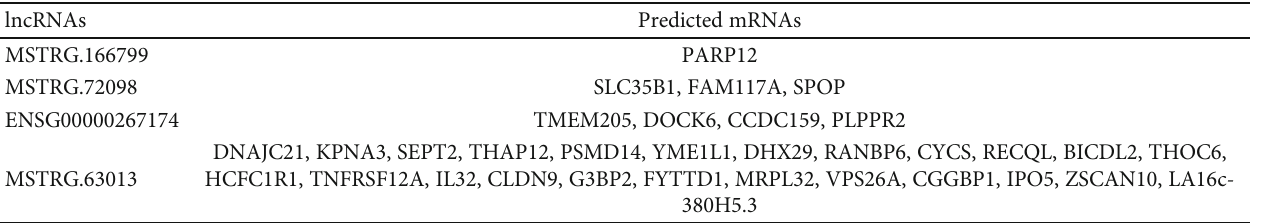
Table 4: Four lncRNAs and their predicted mRNA targets identi fi ed. Predicted